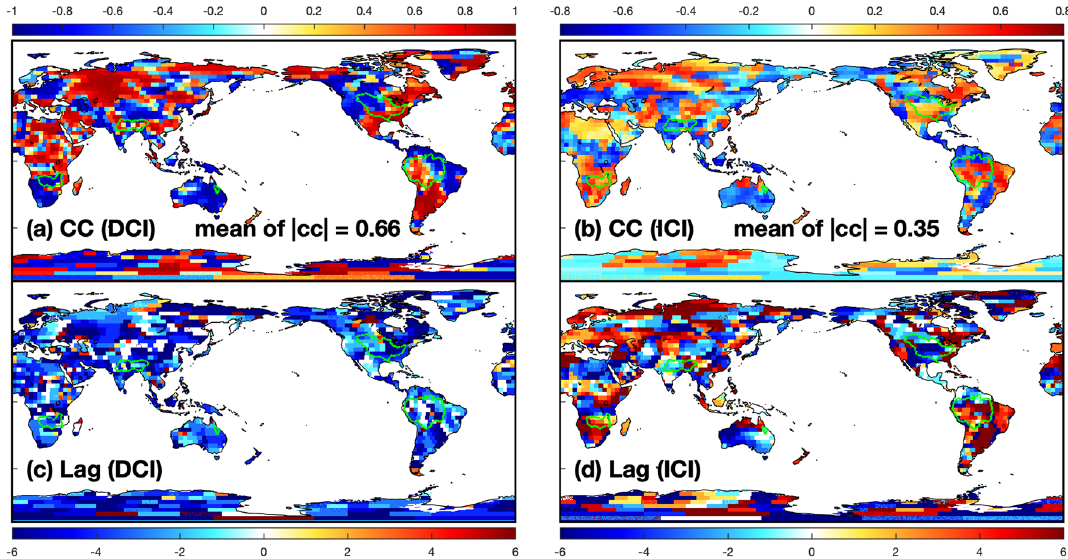
Figure 3. The maximum cross-correlation coefficient and corresponding lag between: ( a,c ) the decadal climate index (DCI) and CSEOF LF-mode at each grid, ( b,d ) the interannual climate index (ICI) and CSEOF HF-mode at each grid. These maps were created using MATLAB (version R2020b; https:// www. mathw orks. com/ produ cts/ matlab.